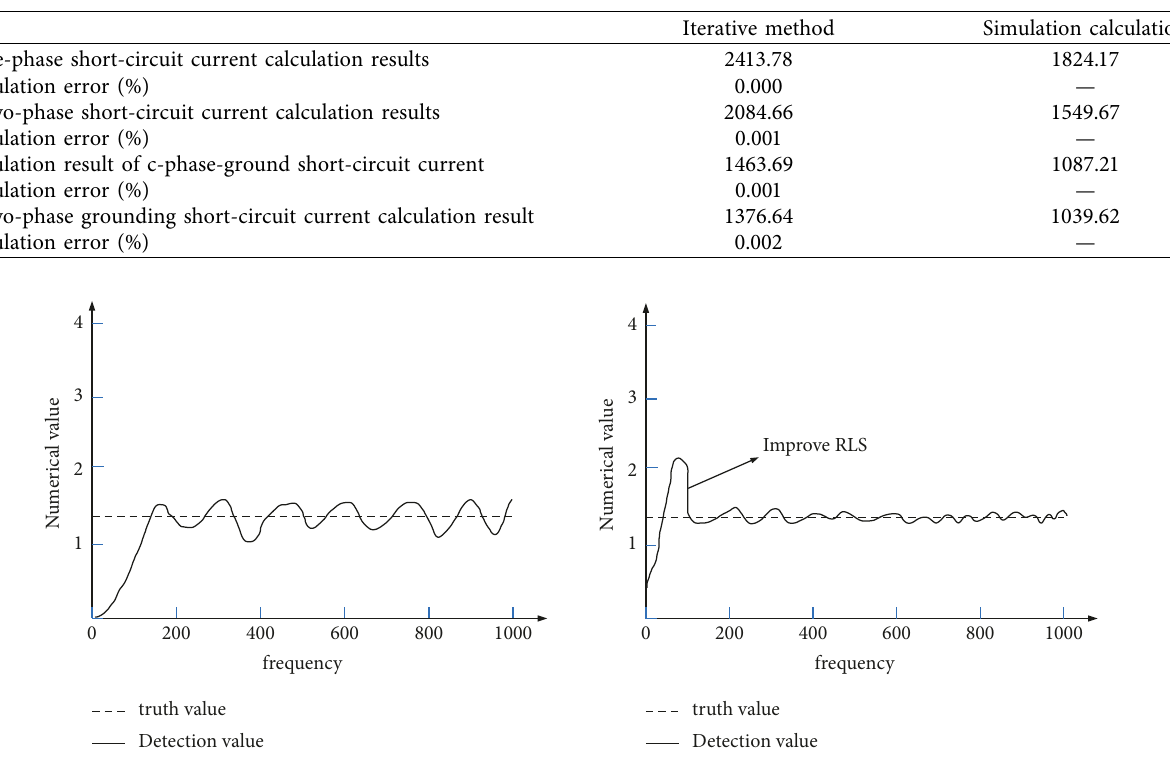
Table 5: Calculation results of short-circuit current in the case of 6-node faults in the distributed power distribution network with inverters.